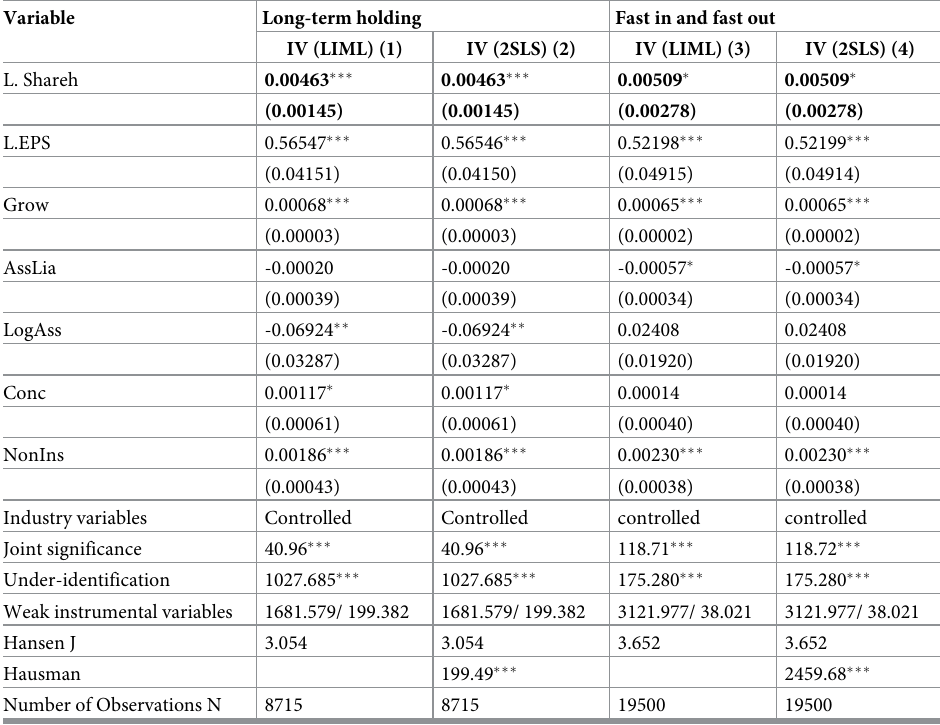
Table 4. Value selection model (the explained variable is earnings per